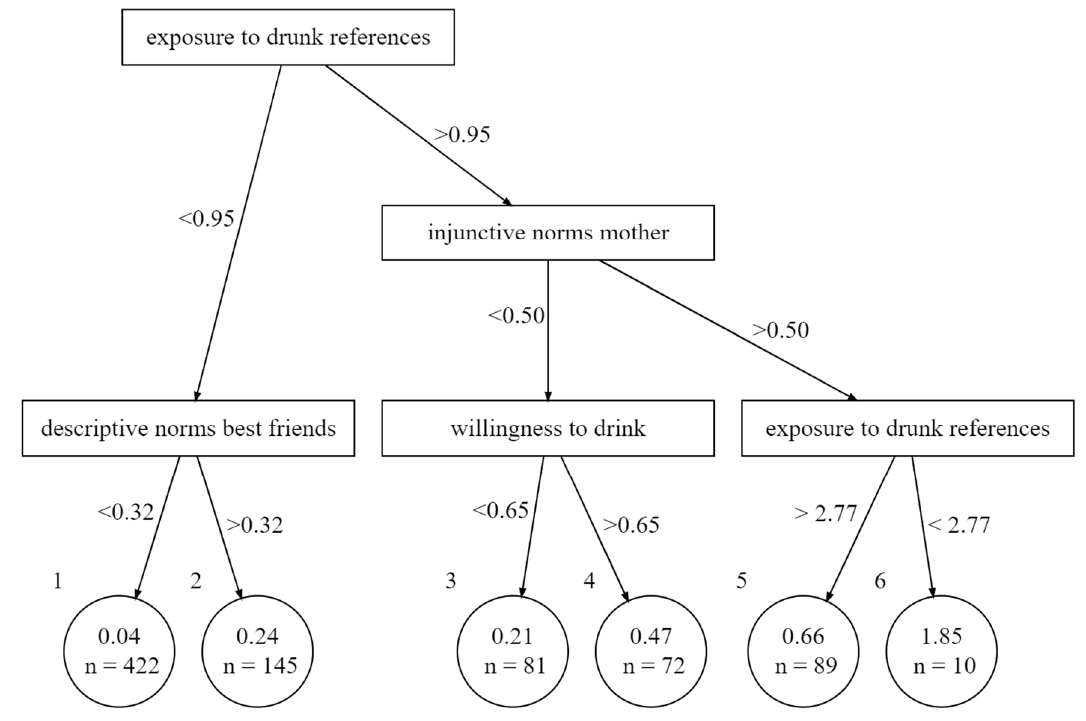
Figure 2. Pruned Tree.